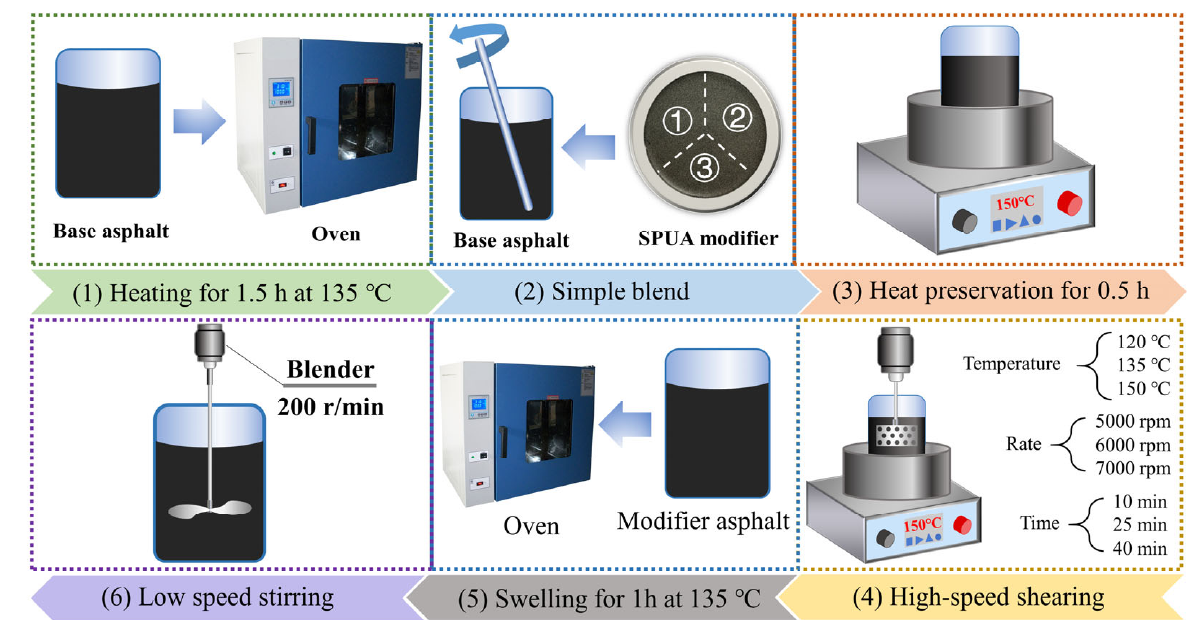
Figure 4. The modified asphalt preparation process.